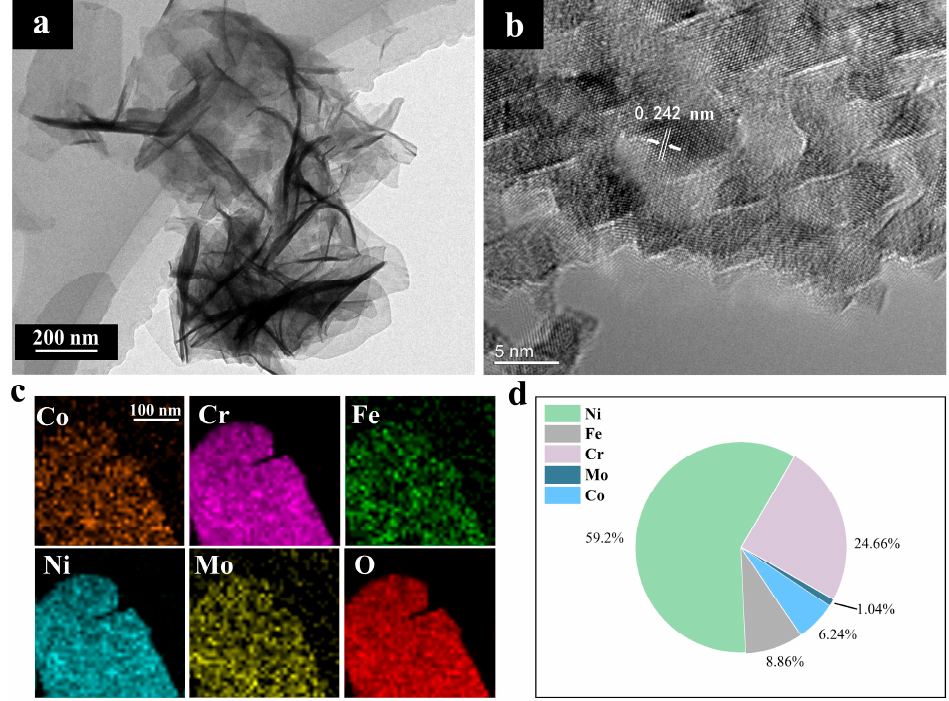
Figure 3. Details of CoCrFeNiMo ‐ LDHs from LDHs ‐ 3 M ‐ 12 h ( a ) TEM image ( b ) HRTEM image ( c ) elemental mapping ( d ) elemental content.